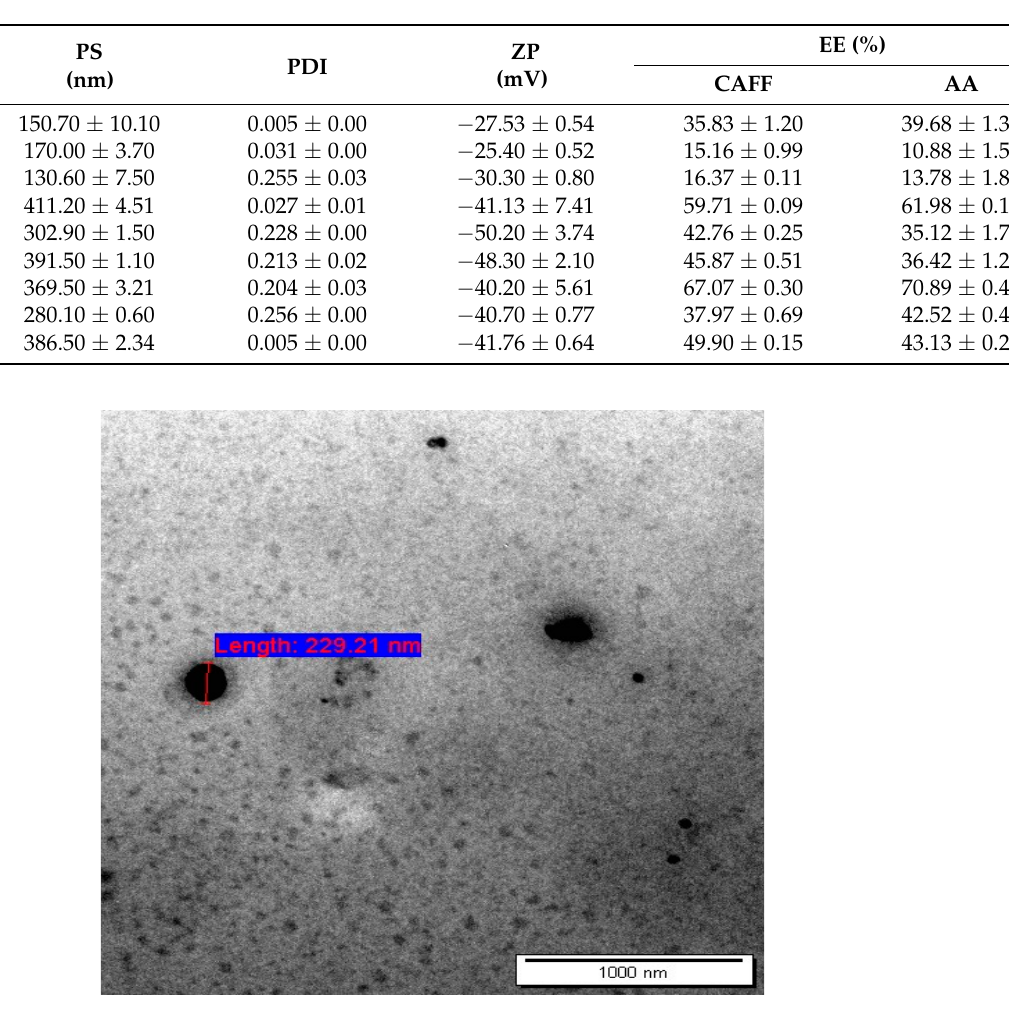
Table 3. The PS, PDI, ZP, and EE% of prepared niosomal formulation. Results are represented by mean ± SD (n = 3).